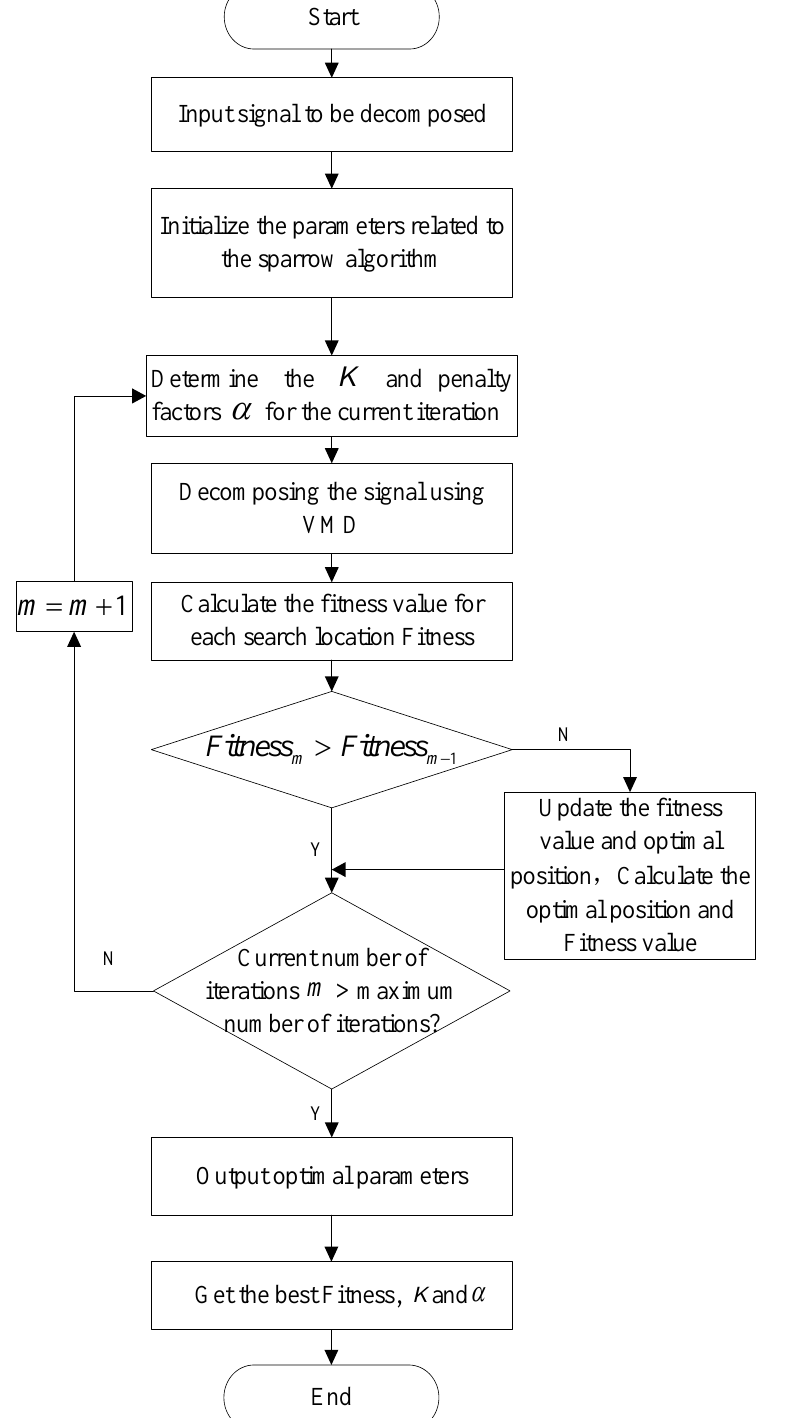
Figure 2. Flow chart of the VMD-SSA algorithm.